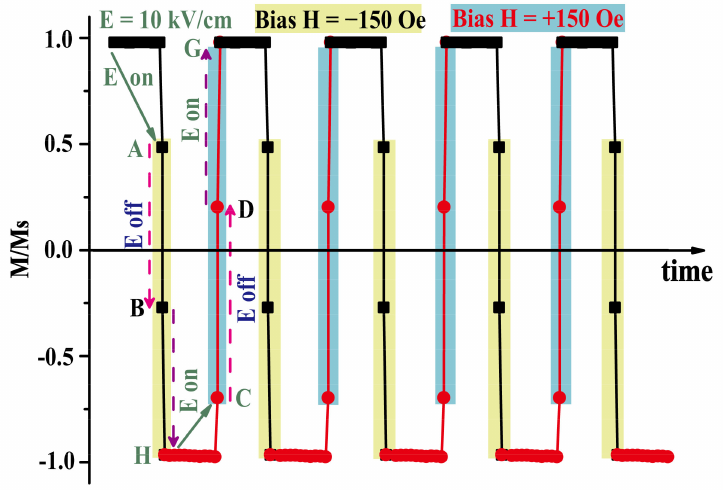
Figure 4. The repeatable 180 ◦ magnetization reversal response to alternating on and off electric fields under a small bias magnetic fields along the [01 − 1]